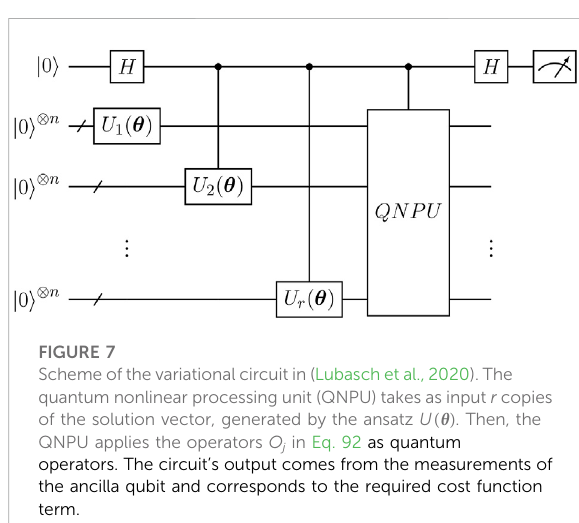
performed via the quantum nonlinear processing unit (QNPU), which is a circuit meant to compute nonlinear functions of